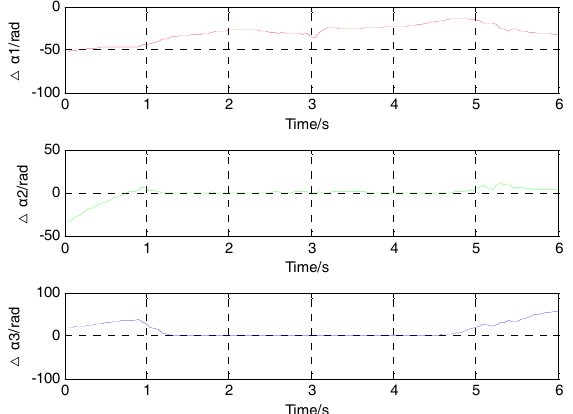
Figure 12. The difference of rotation angle between locating results and actual values in three directions.